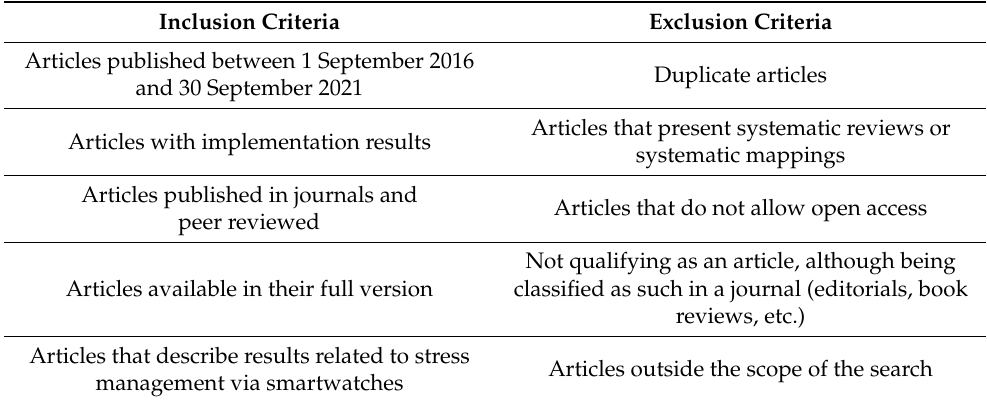
Table 1. Inclusion and exclusion